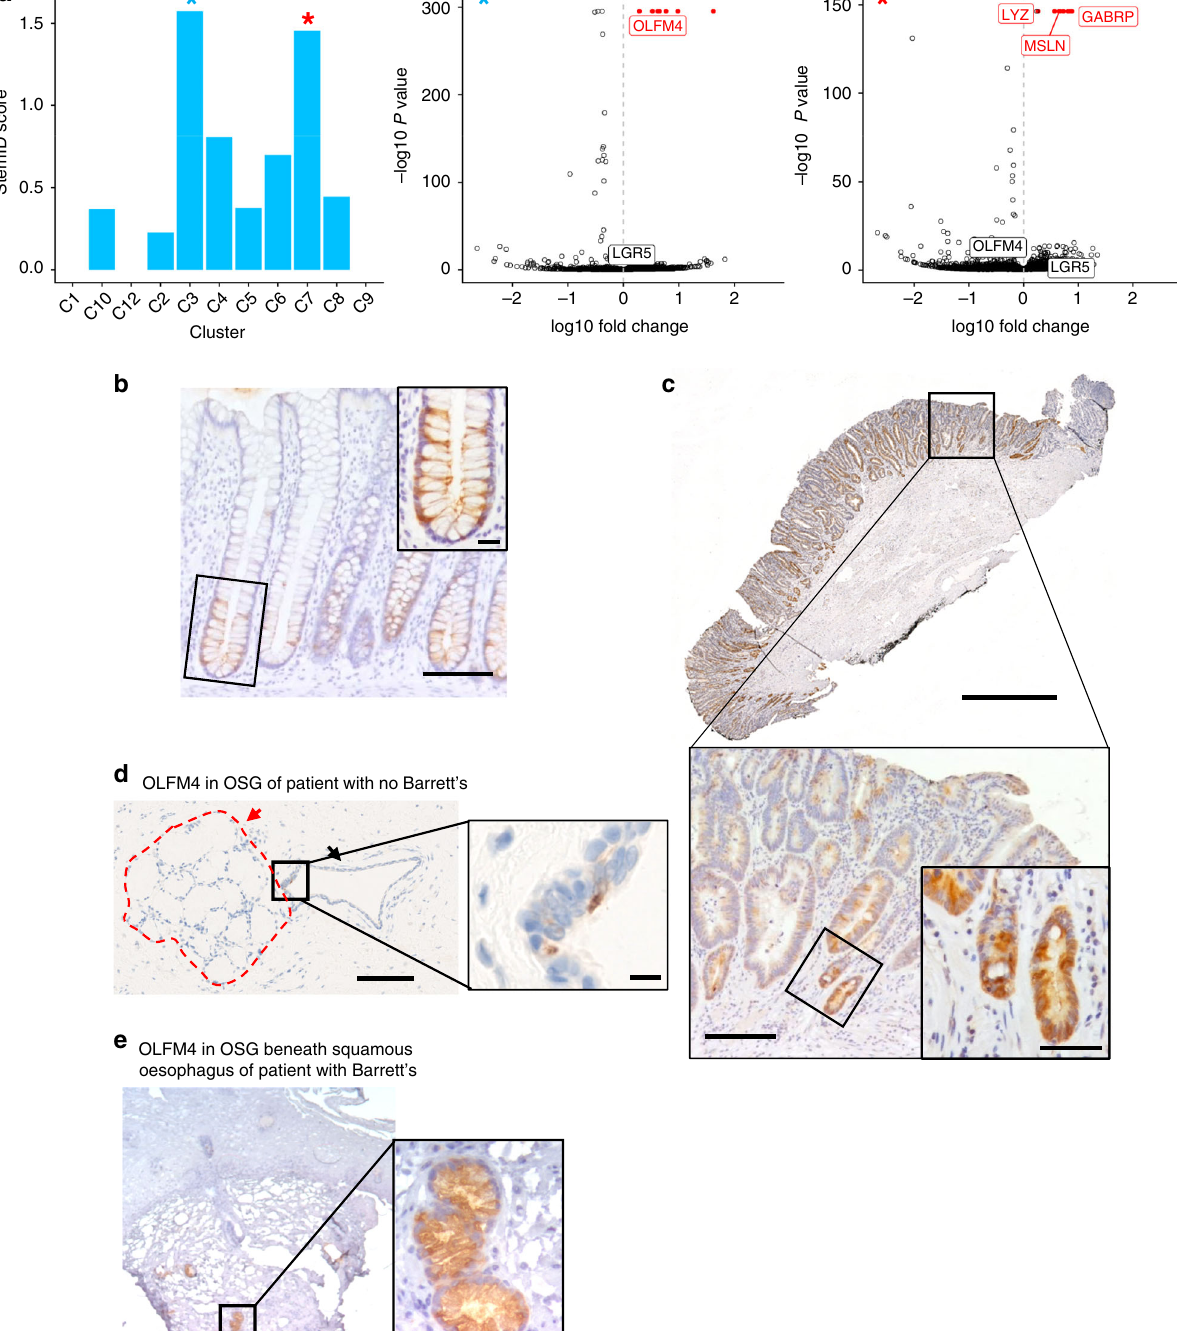
episodes per week with normal endoscopic appearances of the upper gastro- intestinal tract on endoscopic examination, and no histological evidence of oeso- phagitis in the processed